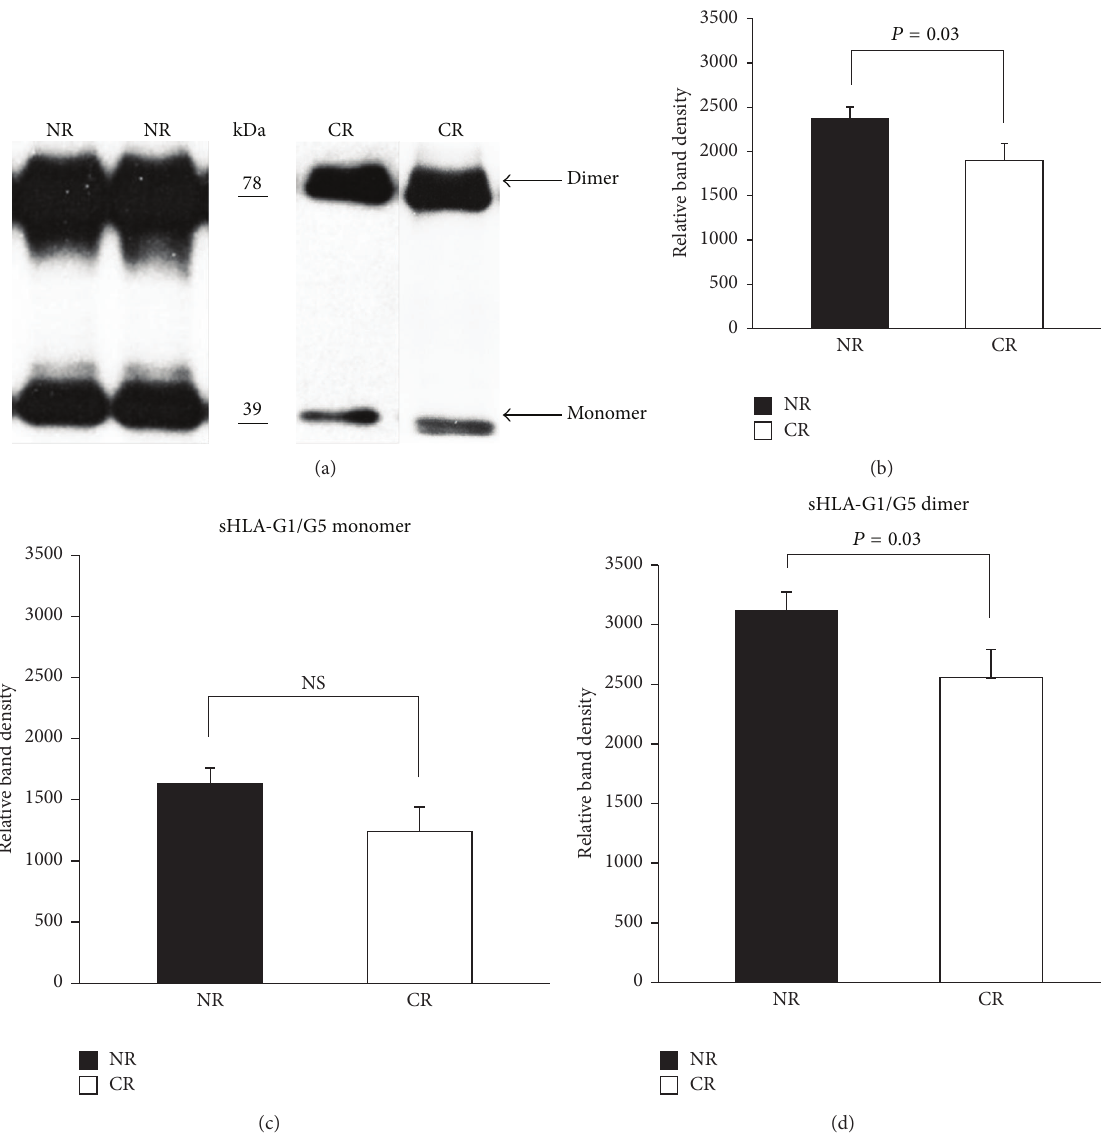
Figure 1: Increased levels of monomer and dimer isoforms of sHLA-G1/G5 in plasma of nonrejecting kidney transplant patients. (a) Plasma from kidney transplant patients was immunoprecipitated with MEM-G/9 mAb. Immunoprecipitates were electrophoresed under nonreducing conditions and Western blot analysis was performed to determine the levels of monomer and dimer of sHLA-G. Representative data from patients with no rejection (NR) and patients with chronic rejection (CR) are demonstrated. Mean relative band density of total sHLA-G (b), sHLA-G monomer (c), and sHLA-G dimer (d) in NR (𝑛 = 42) and CR (𝑛 = 17) patients was determined by densitometry. Data are shown as mean ± SEM and analyzed by Student’s 𝑡 -test. NS: not significant.